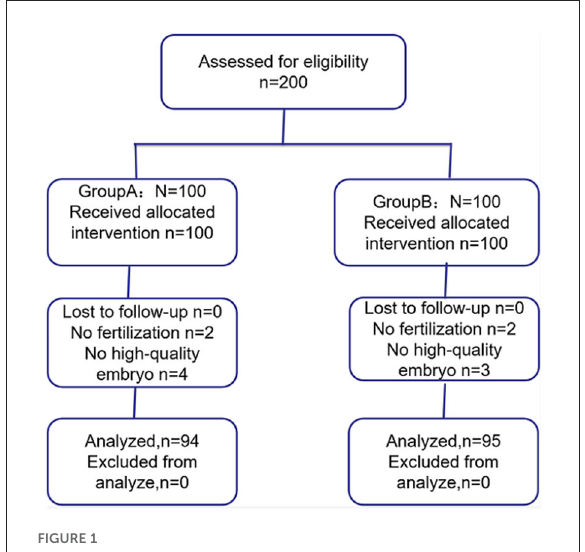
FIGURE1 CONSORT flow diagram for progress of the participants of the randomized